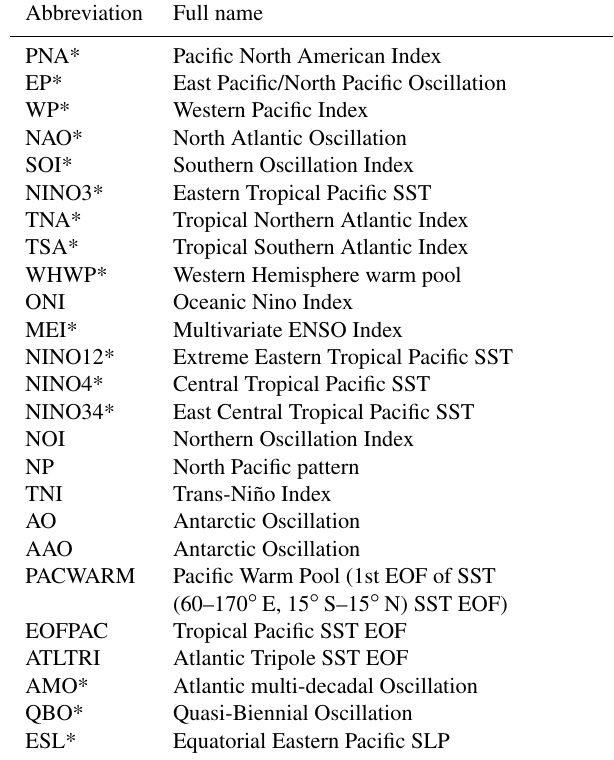
Table 2. Monthly updated climate indices used for seasonal predic-